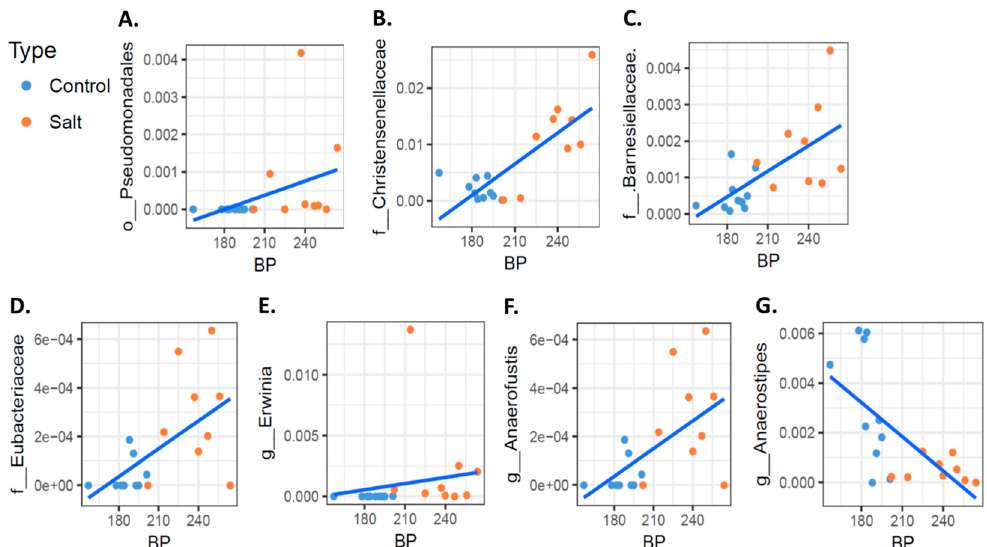
Figure 3. Correlation between blood pressure (BP) and bacterial taxa. Rat’s BP values after 30 days were analyzed for their correlation with specific bacterial taxa; 7 microbial taxa displayed a significant correlation ( q value ≤ 0.1) with BP ( A – G ) using the Multivariate Association with Linear Models (Maaslin) package. Blue dots and red dots depict fecal samples from the high salt diet and controls, respectively.